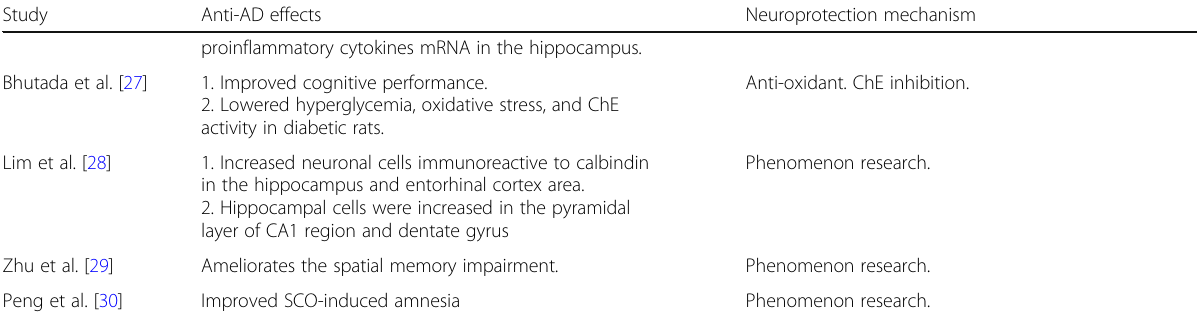
Table 3 Anti-AD effects and underlying mechanisms after berberine treatment of included studies (Continued) Study Anti-AD effects Neuroprotection mechanism